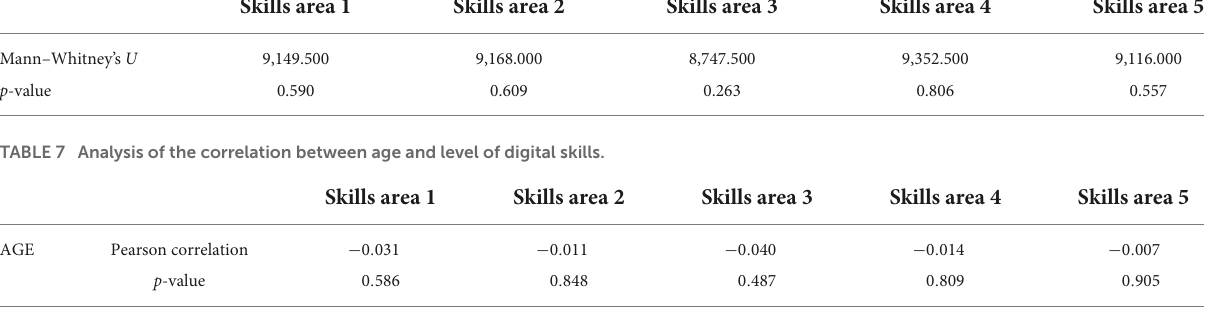
TABLE 8 Analysis of the association between the branch of knowledge and the level of digital skills.